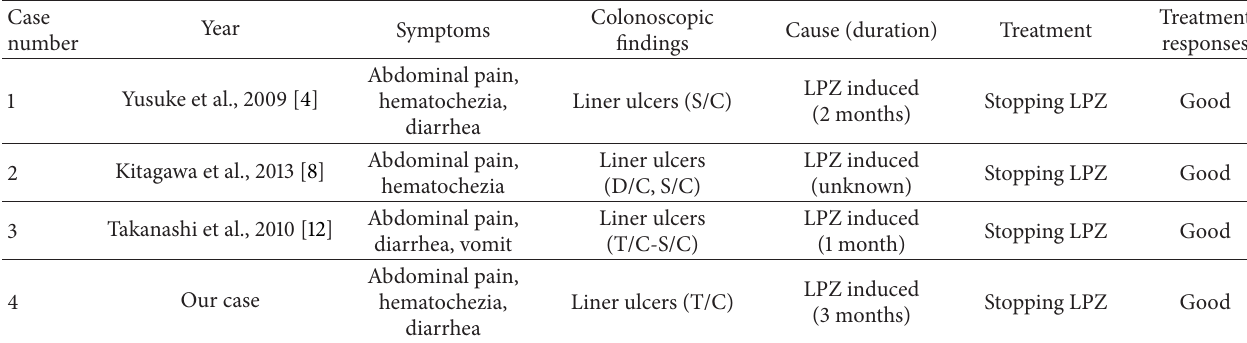
Table 2: The list of case reports developing with acute